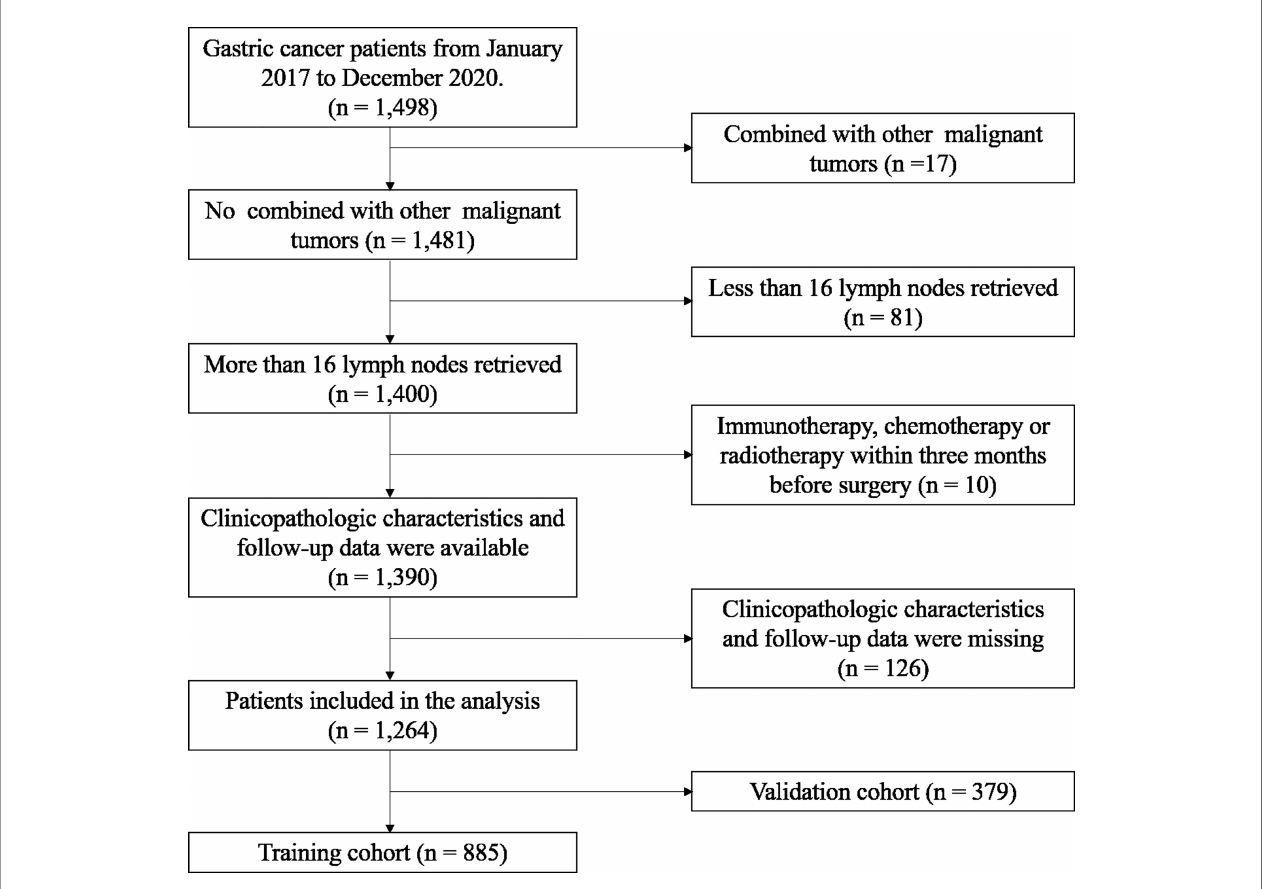
FIGURE 1 | Flowchart of patient cohort de fi